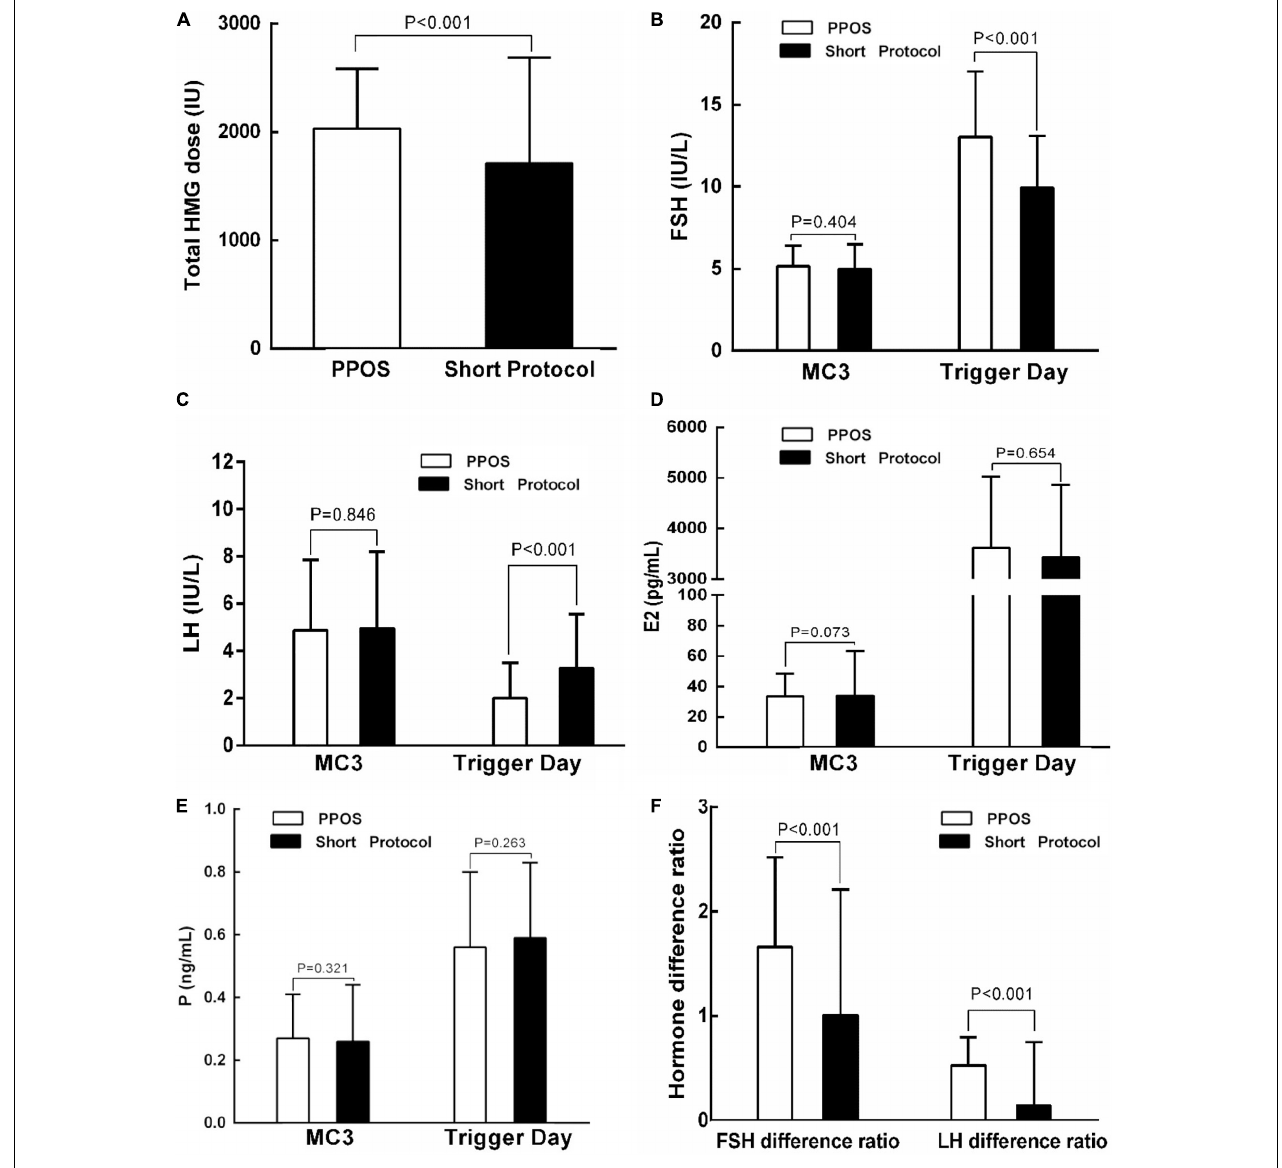
FIGURE 2 | Comparison of the hMG dose and hormone profiles in ovarian stimulation cycles corresponding to the transferred embryos in patients with PCOS treated with indicated protocols. (A) Comparison of the hMG dose between the PPOS and short protocol groups. (B–F) Comparison of the FSH, LH, E2, P, or Hormone difference ratio between the PPOS and short protocol groups on MC3 or on trigger day. PPOS, progestin-primed ovarian stimulation; hMG, human menopausal gonadotropin; MC3, day 3 of the menstrual cycle; FSH, follicle-stimulating hormone; LH, luteinizing hormone; E2, estradiol; P, progesterone.